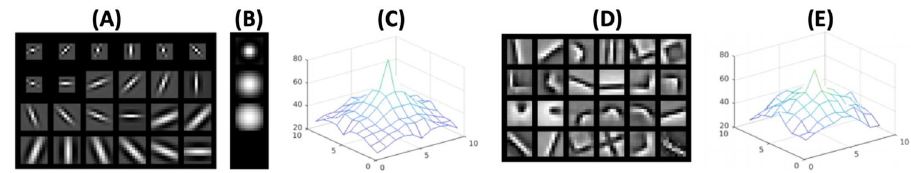
Fig 3. Gabor, Laplacian of Gaussian versus complex-shaped sparse code front-ends. From left to right we have: A : Gabor wavelets with 3 scales and 8 orientations. B . Laplacian of Gaussian kernels with 3 scales. C . The aggregated power spectrum of the Gabor wavelets. D : 24 complex-shaped sparse kernels selected from the 64-element CSC model for use in our Fixed Kernel CNN and Projection Pursuit models. E : Aggregated power spectrum of the complex- shaped sparse